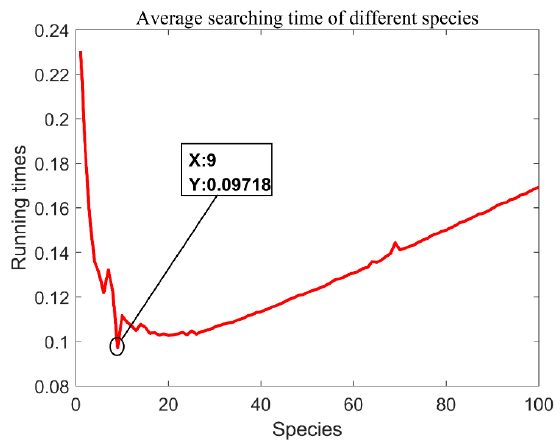
Appl. Sci. 2020 , 10 , x FOR PEER REVIEW Figure 4. The average running time of different species. Figure 4. The average running time of di ff erent species.